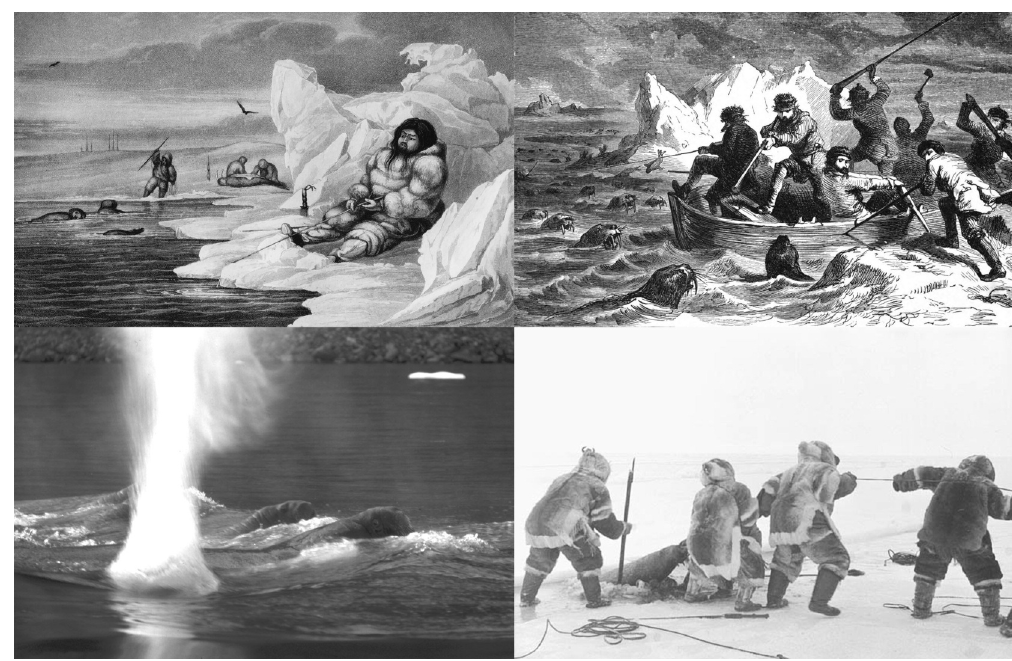
Fig. 4. Historical progression of walrus hunting methods from earliest proceeding clockwise from upper left to most recent: upper left) Inuit catching walruses near Igloolik in the 1820s (Parry 1824:172); upper right) explorers beset by walruses during an unsuccessful hunting expedition in Smith Sound in July 1861 (Hayes 1867:pl. 7); lower right) Inuit retrieving a walrus shot at the ice edge near Igloolik in 1952–1953 using a walrus hide line (Source: © Library and Archives Canada/ PA-129868, credit: R. Harrington /Richard Harrington fonds); and lower left) a hunt in open water south of Ellesmere Island using high-powered rifles in 1977 (credit: R.E.A.